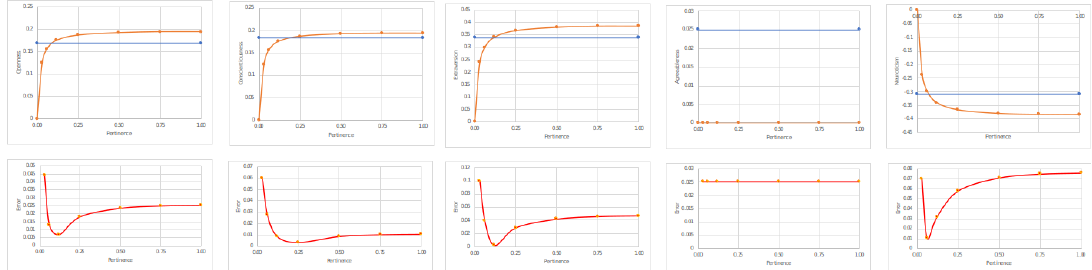
Figure 15. Error graphics from Relief input emotion—OCEANS’s factors.